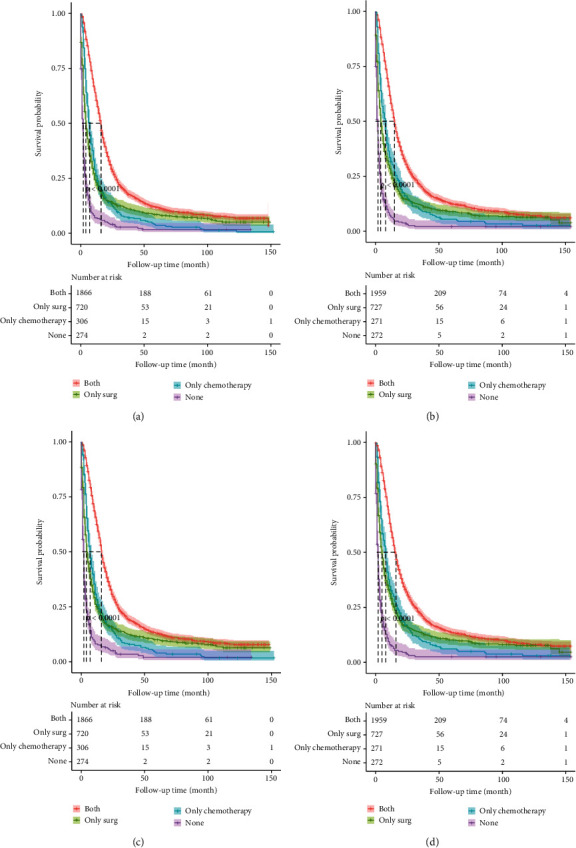
Survival analysis curve for surgery and chemotherapy of the nomograms of training and validation set. Figure (a) is the survival analysis curve of OS in training set. Figure (b) is the survival analysis curve of OS in validation set. Figure (c) is the survival analysis curve of CSS in training set. Figure (d) is the survival analysis curve of CSS in validation set.